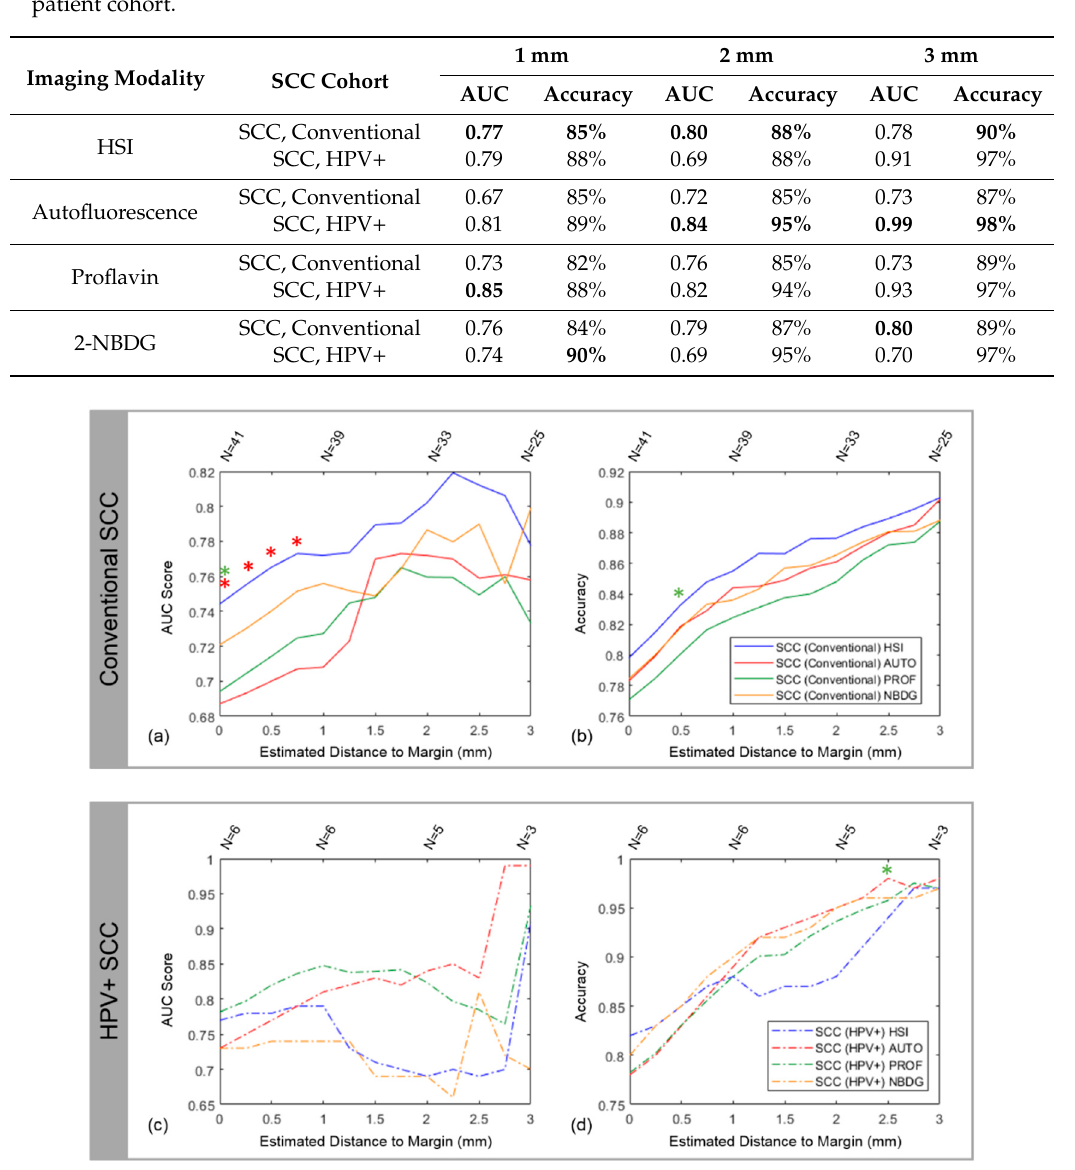
Figure 2. Results from intra-patient training and testing with LDA using HSI, autofluorescence, proflavin, and 2-NBDG. The results for the conventional SCC cohort are shown in ( a ) with AUC score and ( b ) with accuracy. The results for the HPV+ SCC cohort are shown in ( c ) with AUC score and ( d ) with accuracy. Statistically significant results compared to an imaging modality are indicated by a respectively colored asterisk. The sample size (N) is reported above the plots to indicate that not all distances in mm can be estimated from each tissue specimen, so the sample size decreases as the distance estimated increases, which causes noticeable jumps in the plots.